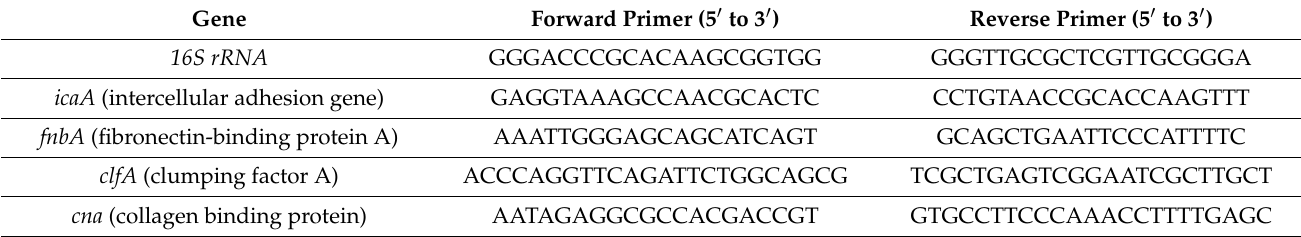
Table 3. Name of target genes and respective primer sets used to quantify mRNA levels in qPCR. Gene Forward Primer (5 (cid:48) to 3 (cid:48) ) Reverse Primer (5 (cid:48) to 3 (cid:48) ) 16S rRNA